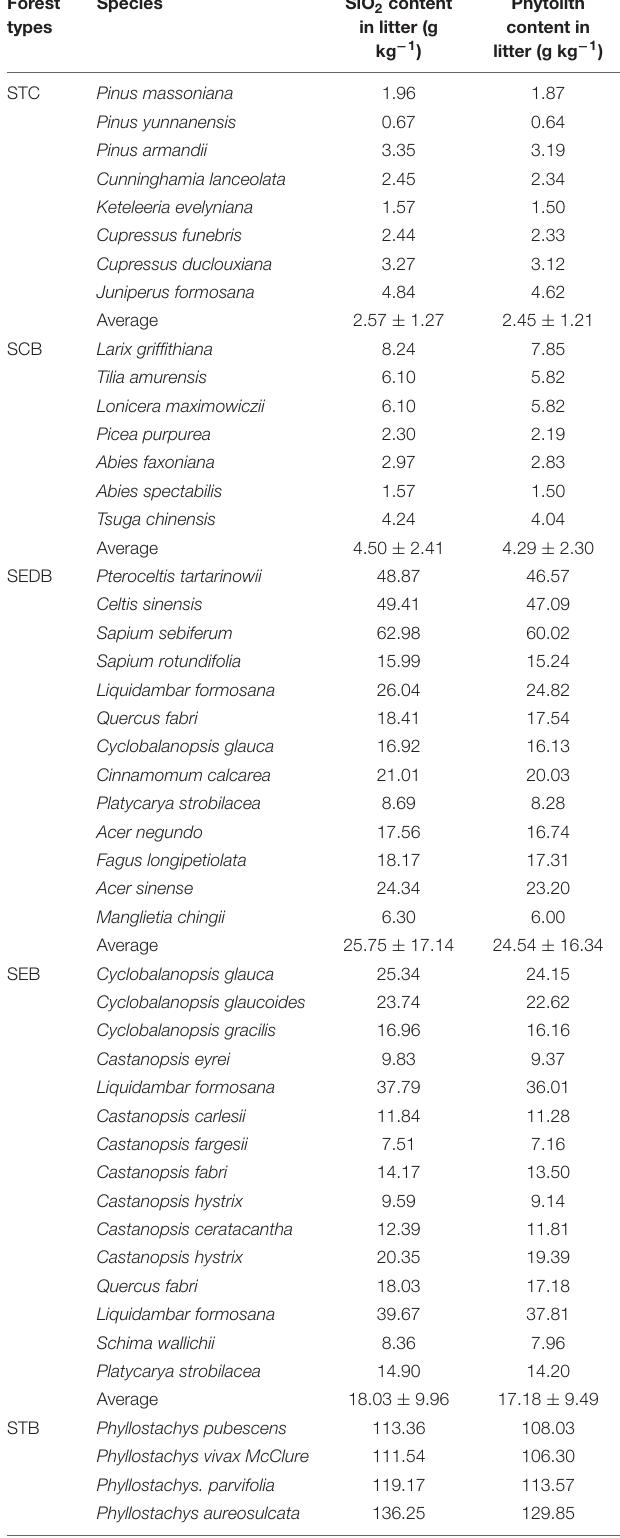
TABLE 2 | SiO 2 and phytolith contents in litter of dominant tree species from six forest types in southern China. Forest